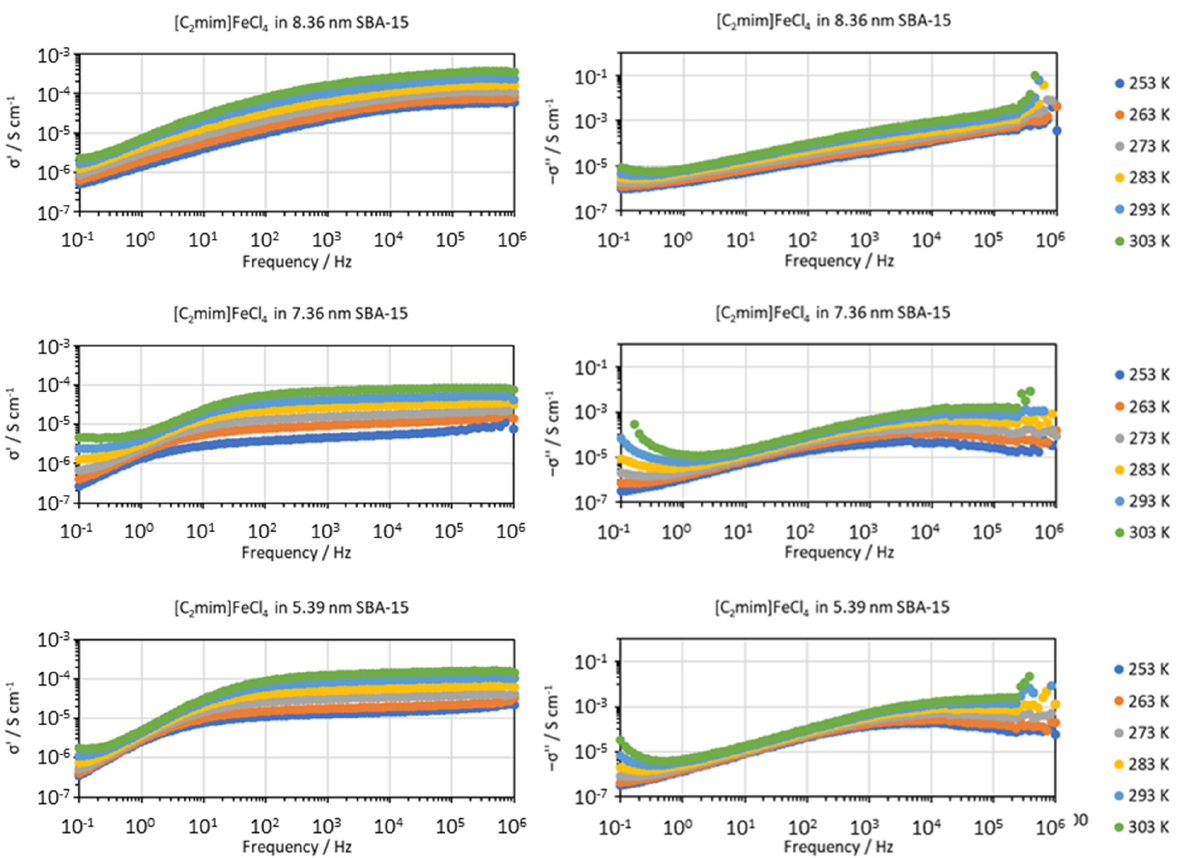
Figure 3. Real and imaginary parts of the complex conductivity function for [C 2 mim]FeCl 4 confined within SBA-15 mesoporous silica.